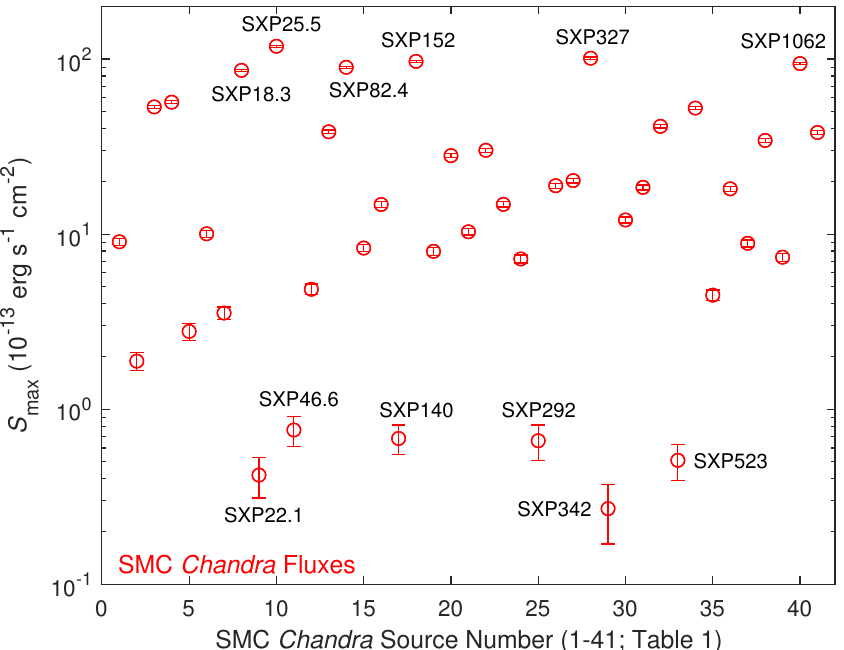
Figure 4. Sample of maximum X-ray fluxes for the SMC Chandra ACIS-I sample in Table 1. Owing to Chandra ’s unprecedented accuracy and sensitivity, errors are extremely small for all sources.